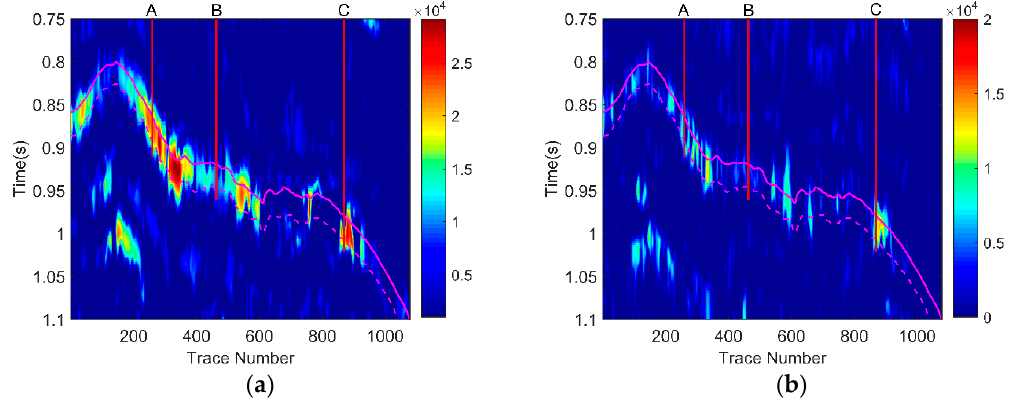
Figure 8. Common frequency sections based on EWT-SET ( a ) at 30 Hz; ( b ) at 40 Hz.